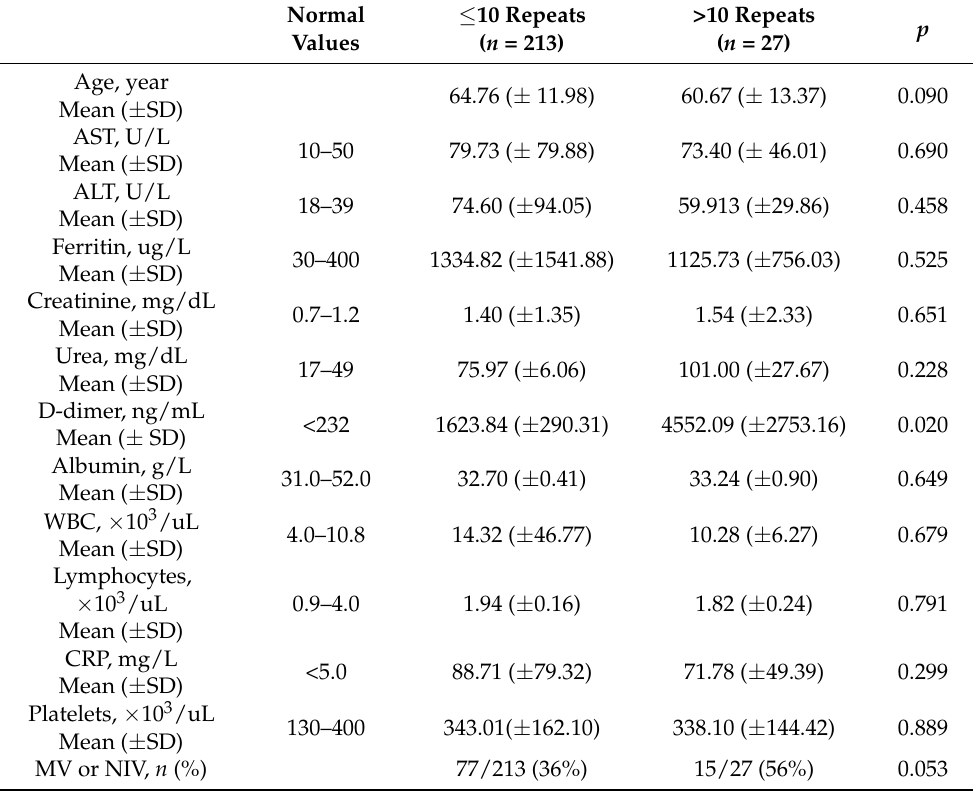
Table 2. Univariate regression analysis for the considered parameters in the severe COVID-19 sub- cohort ( n = 240) with >10 or ≤ 10 repeats in the C9orf72 hexanucleotide repeat expansion (HRE) region. ≤ 10 Repeats Normal Values ( n = 213)